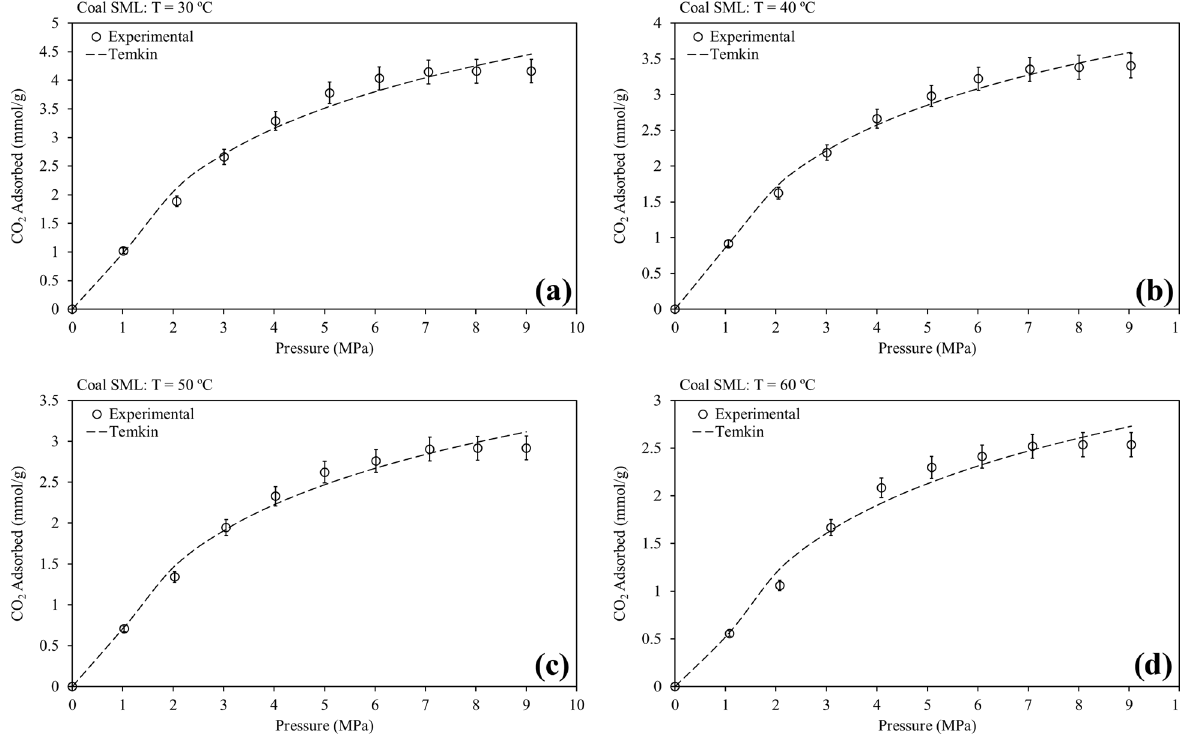
Fig. 6 Temkin isotherm model fit for pure CO 2 sorption on Coal SML at a 30 ºC, b 40 ºC, c 50 ºC, and d 60